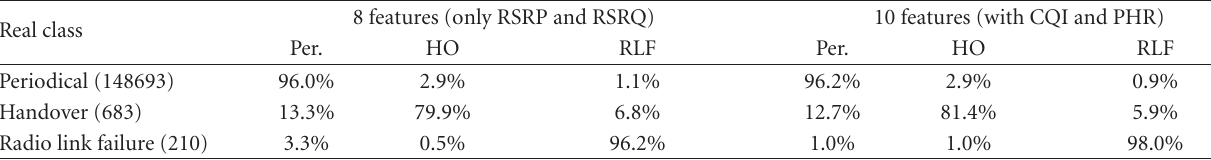
Table 3: Problem-simulation confusion matrices.